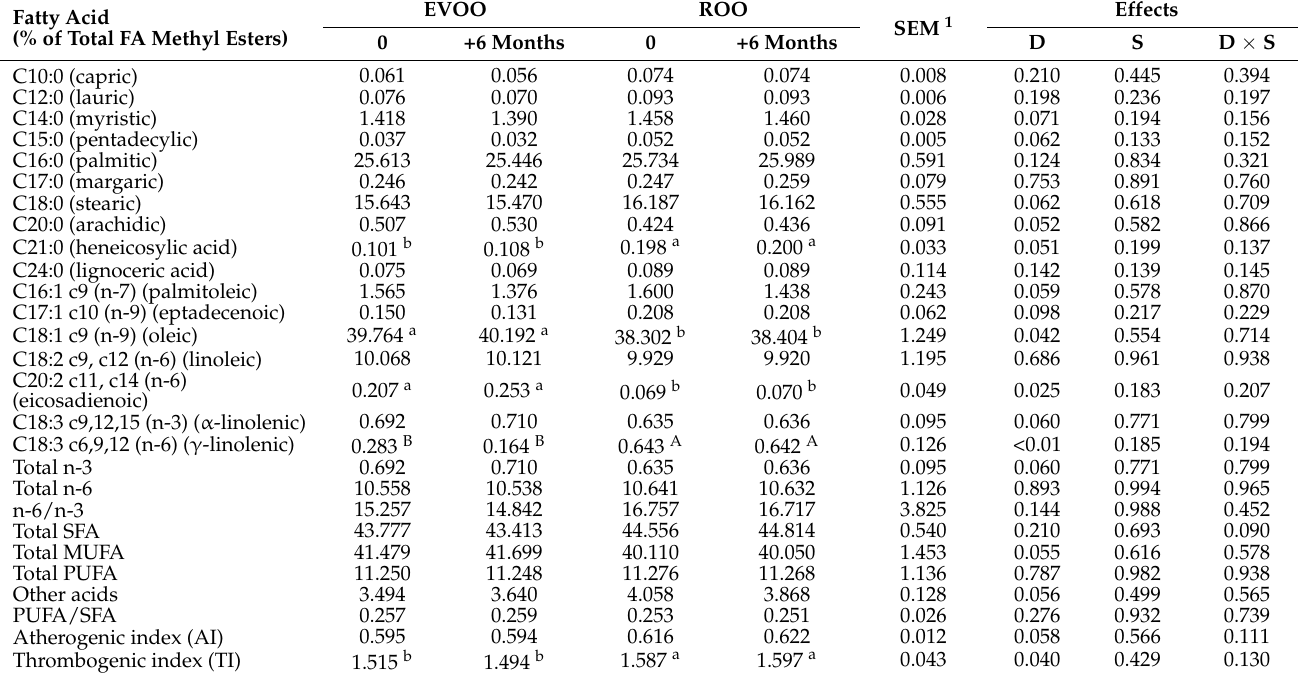
The fatty acid profile of capocollo is shown in Table 6. Dietary refined olive oil determined a significant increase of the concentration of C18:3 c6,9,12 (-linolenic; p < 0.01) and C21:0 (heneicosylic acid; p < 0.05) at both storage times, while it lowered ( p < 0.05) the concentration of C18:1 c9 (n-9) (oleic) and C20:2 c11, c14 (n-6) (eicosadienoic) acids. The thrombogenicity index was significantly ( p < 0.05) lower at both storage times following the EVOO diet. Table 6. Effect of the pigs’ diet (EVOO and ROO) and of the storage period (0 and +6 months) of Capocollo di Martina Franca dry-cured meat on fatty acid composition. Fatty Acid (% of Total FA Methyl